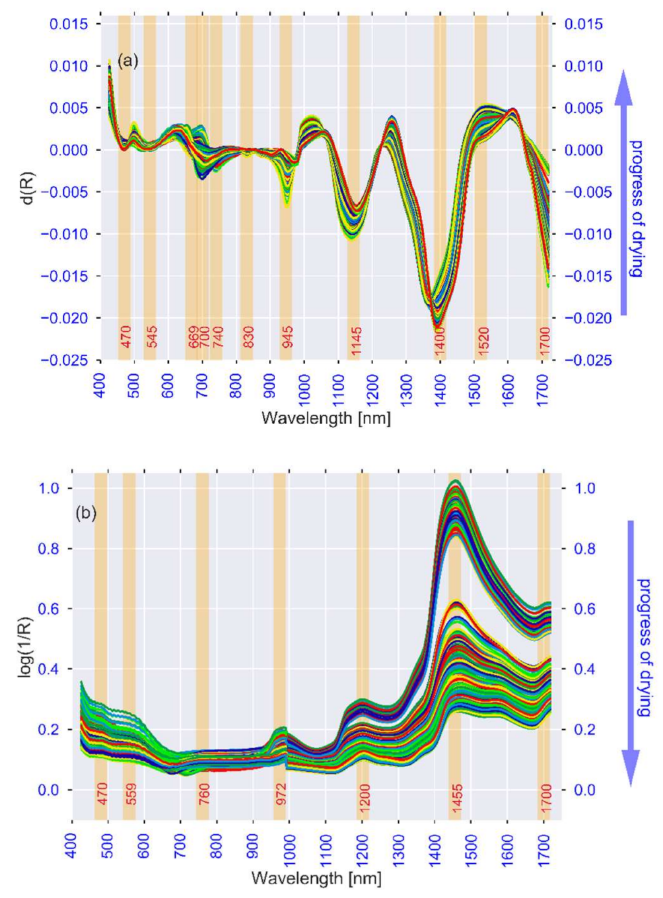
Figure 2. Spectral signatures of cocoyam slices over the ranges 400–1700 nm. ( a ) The first derivative of reflectance, ( b ) Absorbance